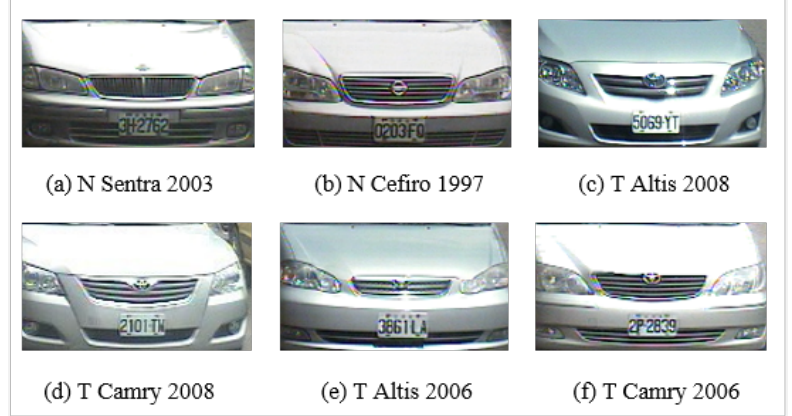
Figure 2. Intra-make ambiguity problems between ( a ) Nissan Sentra 2003 and ( b ) Nissan Cefiro 1997; ( c ) Toyota Altis 2008 and ( d ) Toyota Camry 2008; and ( e ) Toyota Altis 2006 and ( f ) Toyota Camry 2006 in the NTOU-MMR dataset. Intra-make ambiguity results when different vehicles (models) from the same company (make) have a comparable shape or appearance.